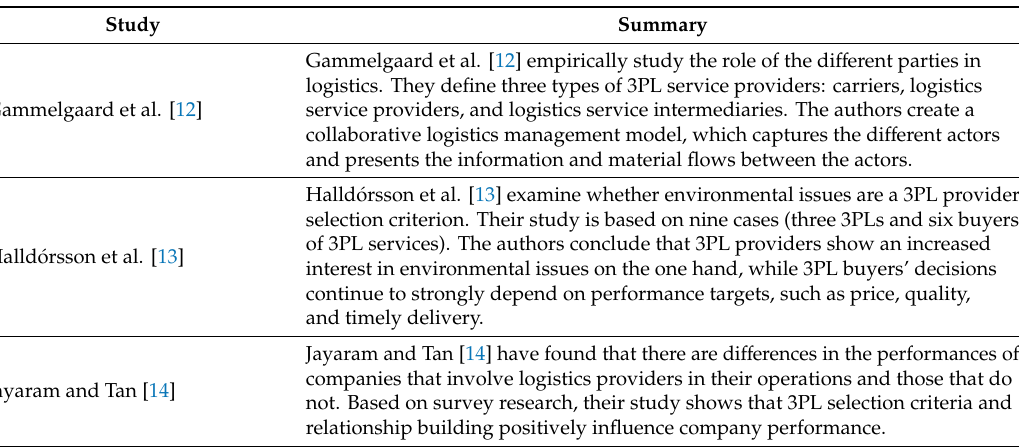
Table 1. Selected papers on third-party logistics